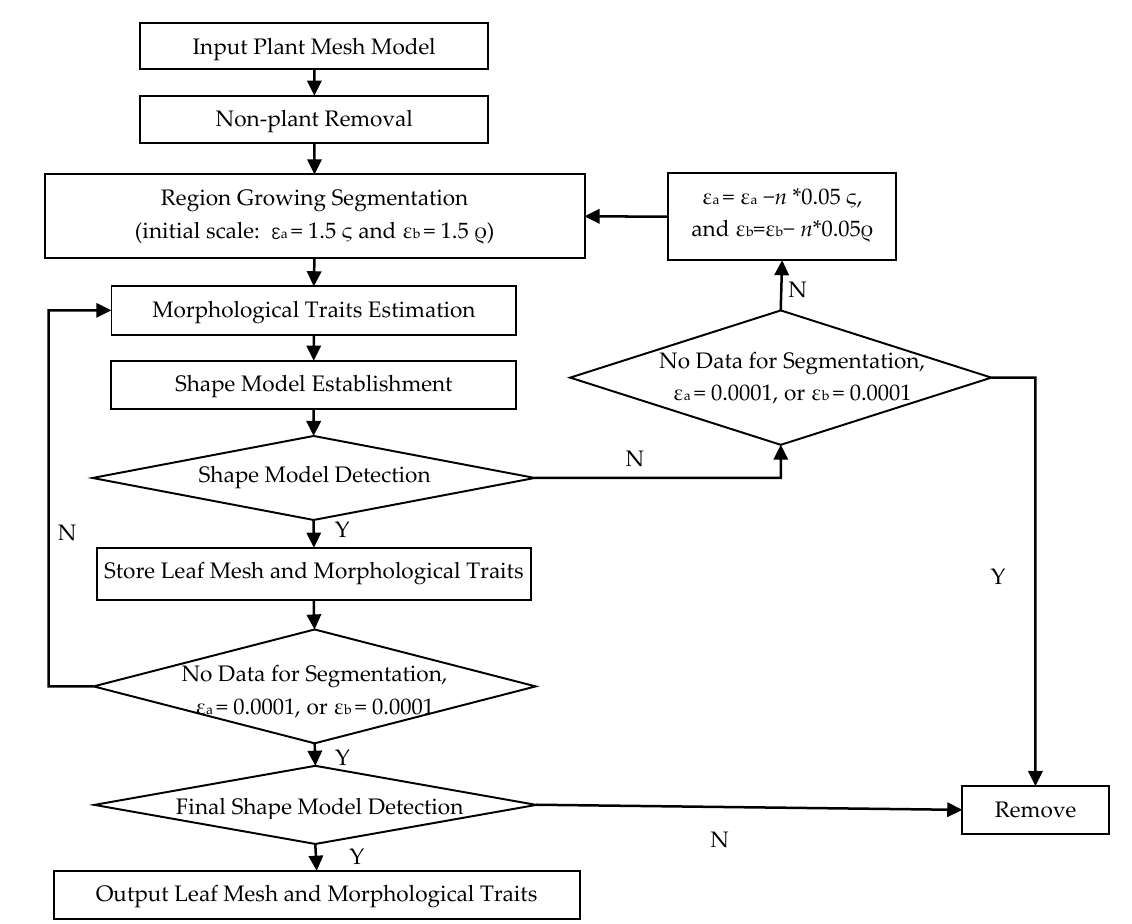
Figure 4. The multi-level region growing segmentation method based on the shape model. The multi-scale segmentation method proposed in this paper is an iterative process.